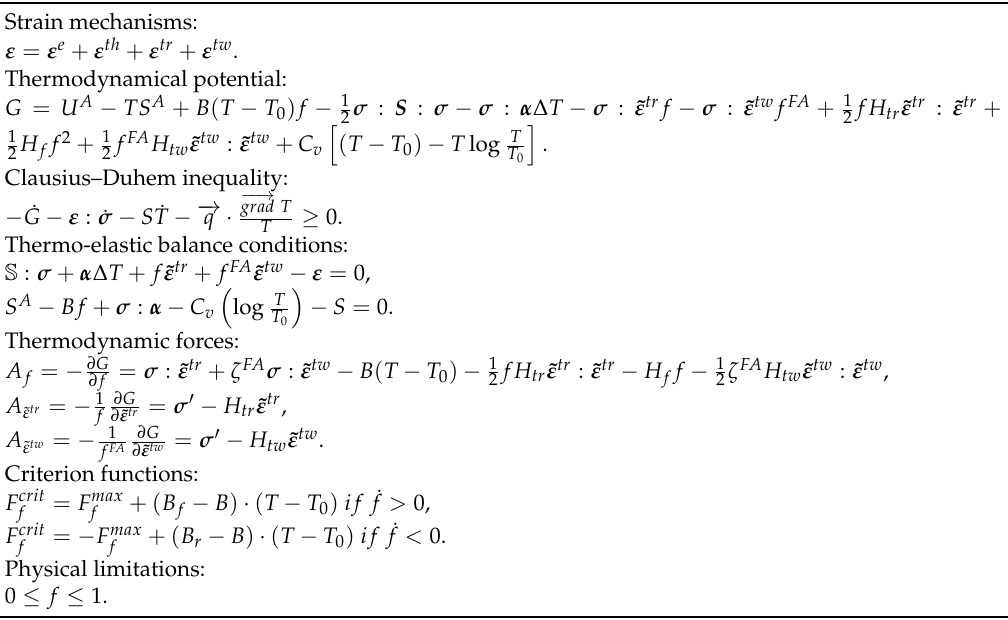
Table 1. Summary of the control equations for the SMA model.